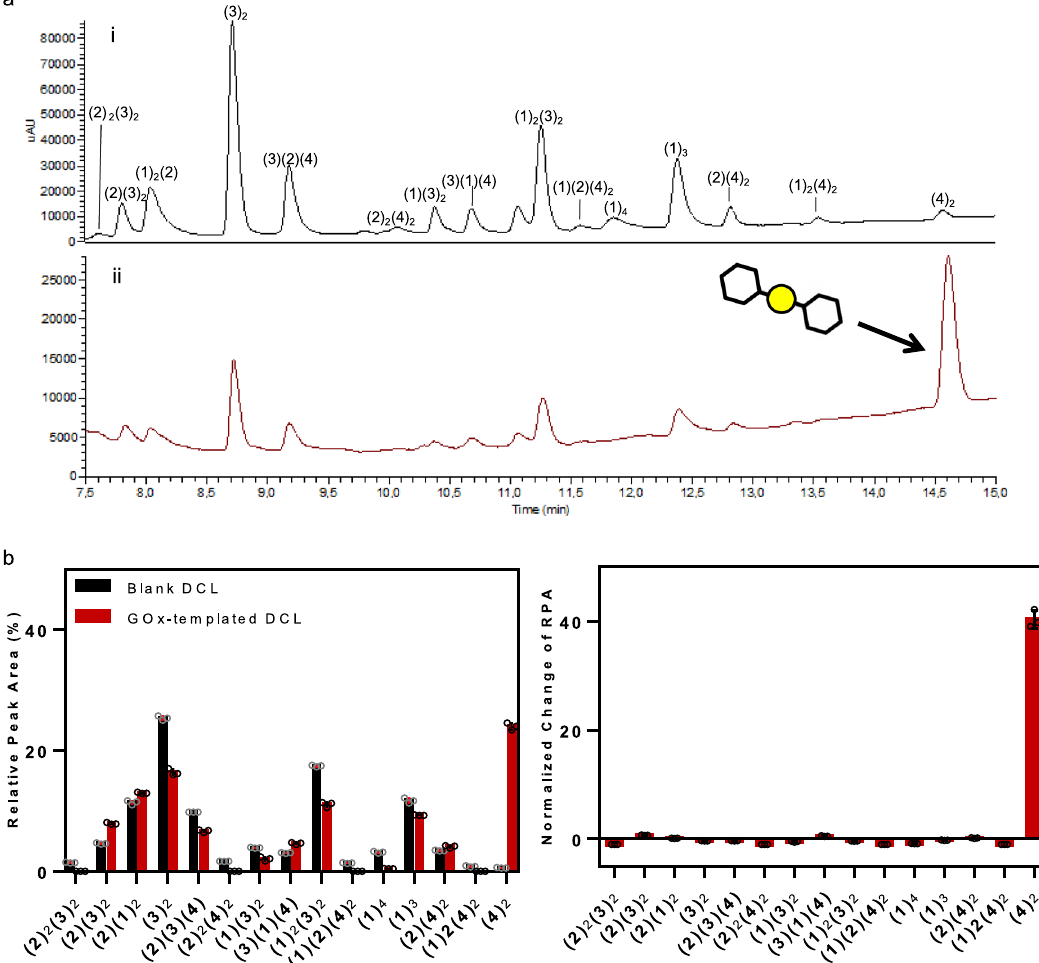
Fig. 9 GO x -DCL by HPLC. Conditions: building blocks 1 – 2 (95 μ M each) and 3 – 4 (190 μ M each), Sec ox (5% mol, 28.5 μ M), GO x (57 μ M), Tris buffer (20 mM, pH 7.8), T = 6 °C, 2.5% (v/v) DMSO. Yellow circle (S – S), black hexagon (benzene ring). a DCL chromatograms after 24 h (i) in absence, blank (ii) and presence of GO x , templated. b GO x templated effect relative peak area (RPA) and normalized change of RPA in the presence and absence of Sec ox (Supplementary Tables 11 and 12). DCC experiments were carried out in triplicate. Mean ±